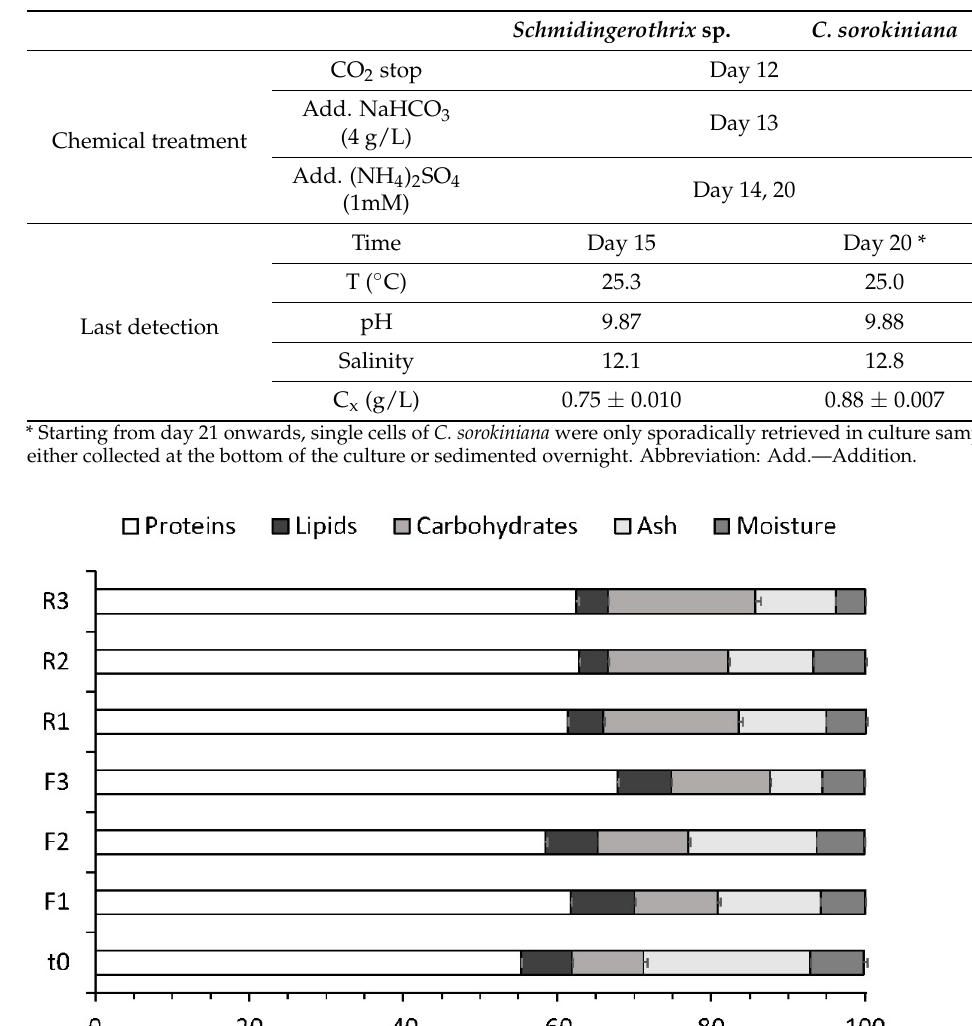
Figure A3. Phytonutrient content (as % of C-phycocyanin, chlorophyll a, and total carotenoids) for samples of A. platensis BEA 1257B biomass collected at the time of inoculation (t0), during the first